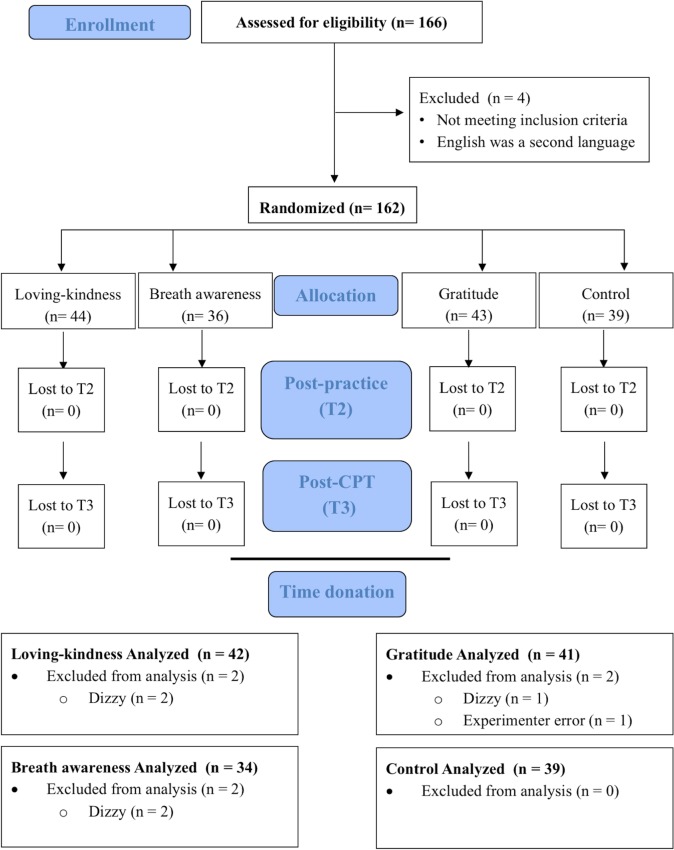
CONSORT diagram.